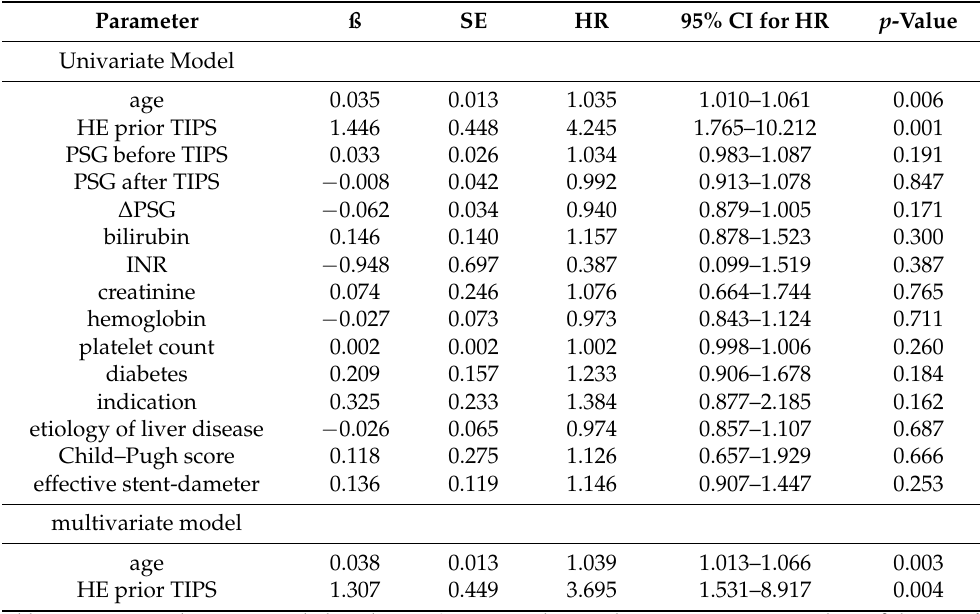
Table 2. Predictors of HE within 12 months after TIPS